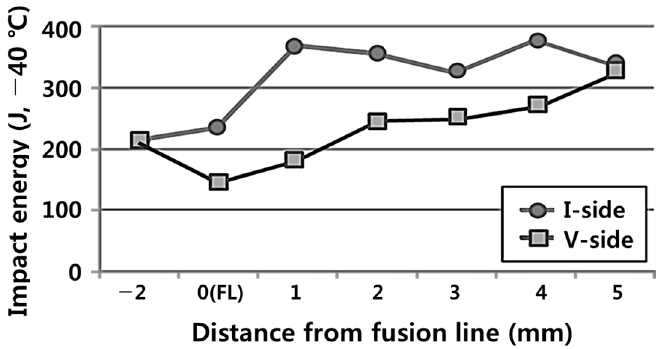
Figure 11. CVN-absorbed energy as a function of notch location.